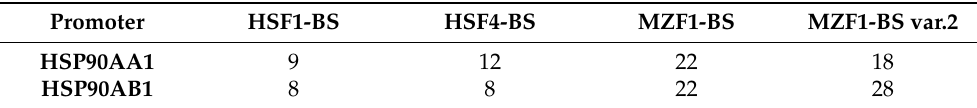
Table 4. The number of binding sites for HSF1, HSF4 and MZF1 in the promoter regions of the HSP90AA1 and HSP90AB1